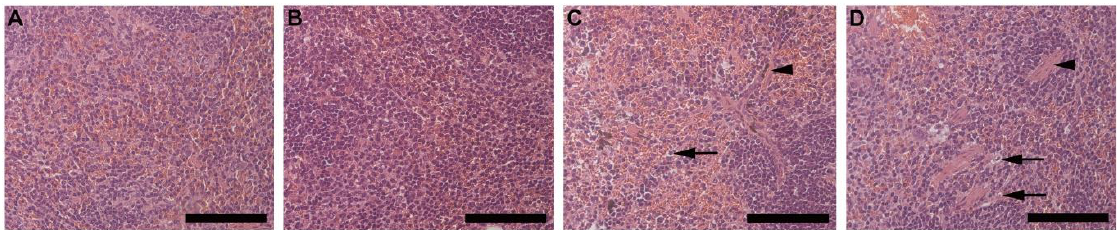
Figure 9. Histology of the spleen harvested from CD females, ( A ); CD males, ( B ); HFD females, ( C ); and HFD males, ( D ) showing the red pulp of the spleen, consisting of the parenchyma and surrounding sinusoids. HFD females, C and males, D displayed cell swelling and necrosis (black arrow), and visible fibrotic lesions (arrowhead). The fibrotic lesions were more prominent and larger in the HFD males. Scale bar: 100 µm .